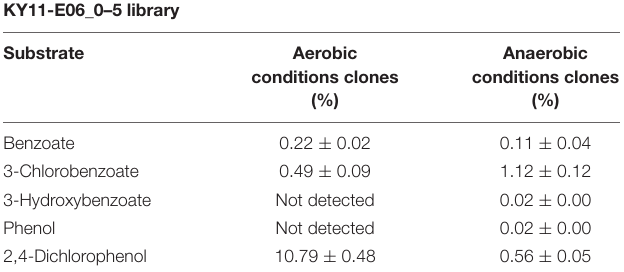
TABLE 1 | Percentage of clones with green fluorescence in response to specific substrates, calculated for an area with 1.00 × 10 3 cells that emitted high